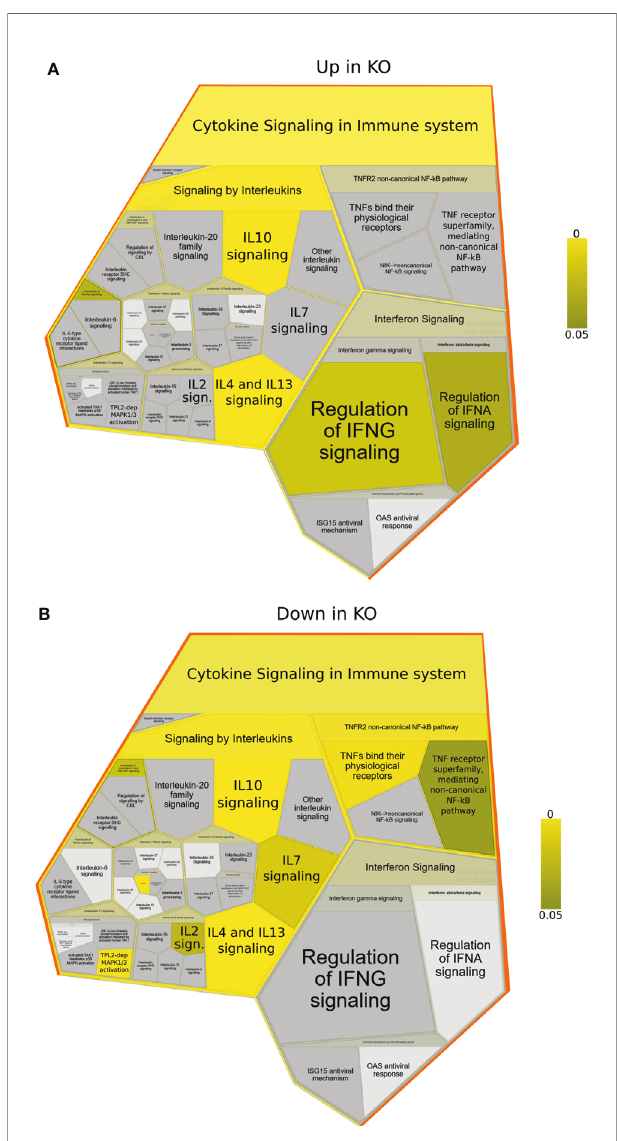
FIGURE 3 | Reactome foam plots identifying enriched pathways using genes (A) upregulated or (B) downregulated in NFKB1 -/- (KO) macrophages (either untreated or LPS treated) compared to wild type controls. Yellow bar indicates p